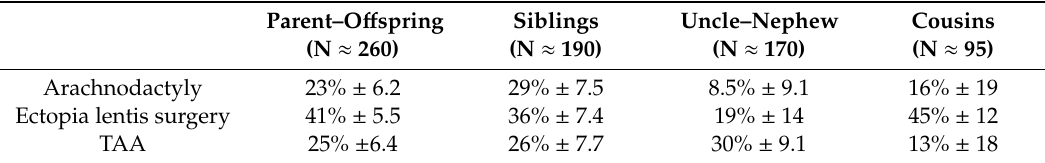
Table 2. Phenotypic correlations between distant